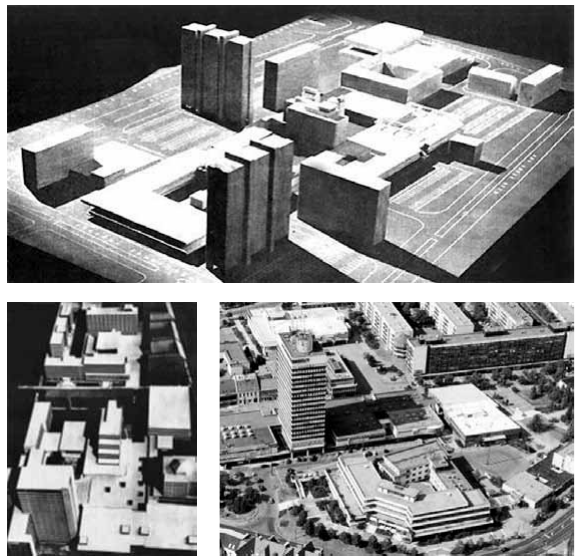
figs 9–11. new centres of public institutions and services